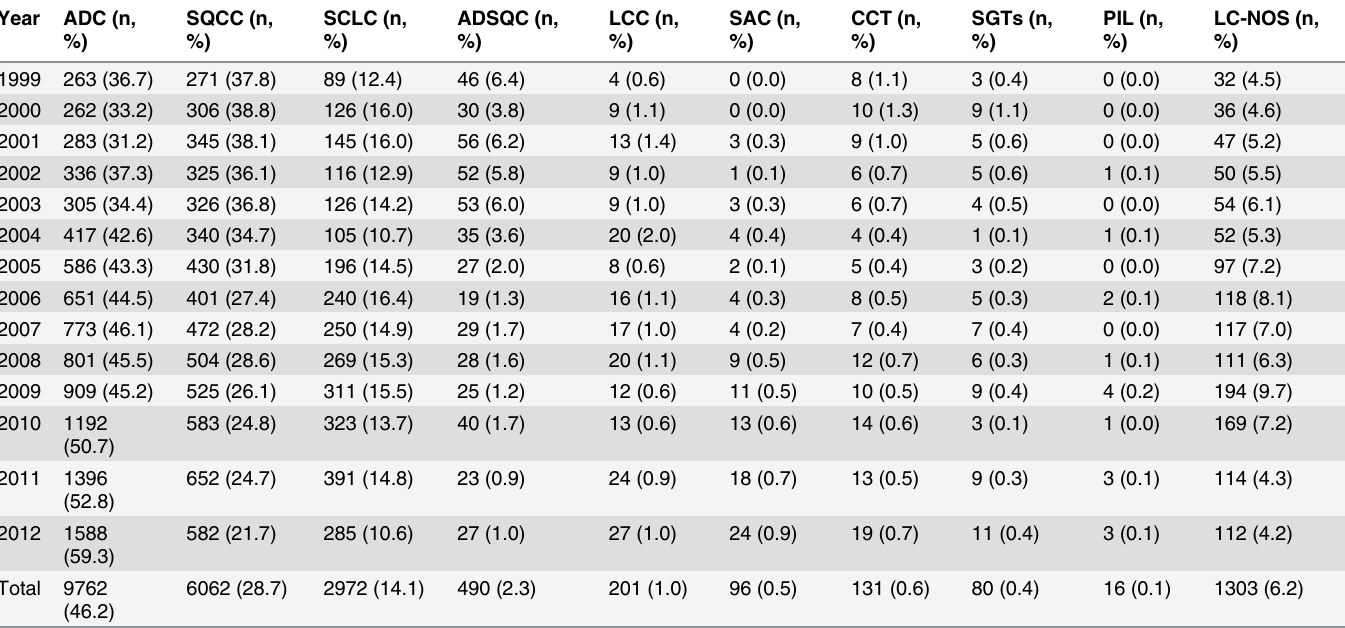
Table 1. Distribution of histology among pathologically confirmed lung cancer cases in CHCAMS from 1999 –